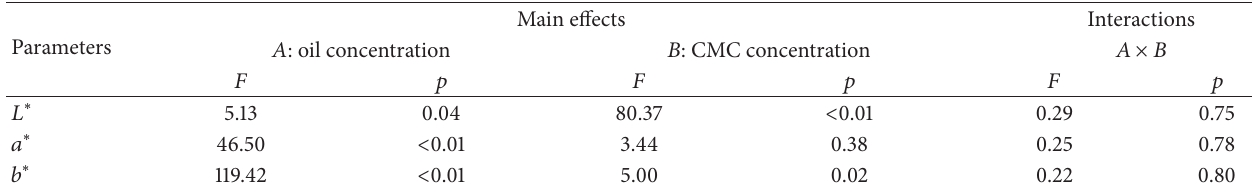
Table 5: Two-way ANOVA of lightness ( 𝐿 ∗ ), red-green component ( 𝑎 ∗ ), and yellow-blue component ( 𝑏 ∗ ) for O/W nanoemulsions based on olive oil with different CMC concentrations. 𝐹 and 𝑝